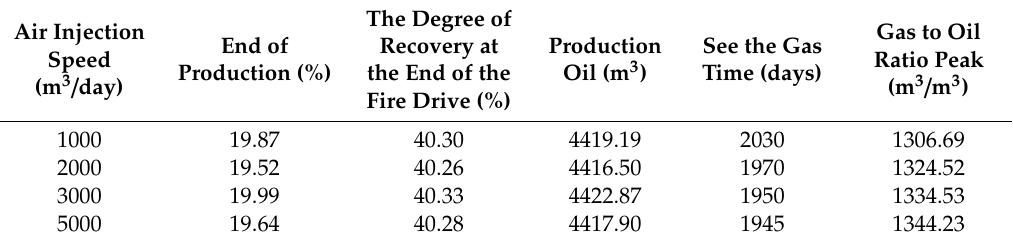
Figure 4. Comparison of production indicators under di ff erent air injection speeds. ( a ) recovery degree; ( b ) cumulative oil production; ( c ) gas-oil ratio; and ( d ) gas production rate. Table 5. Dynamic production index under di ff erent air injection